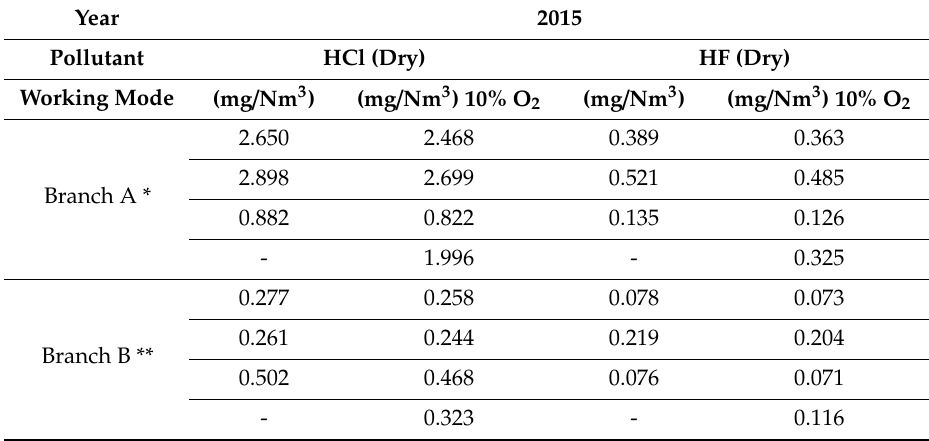
Table 3. Measurement results of HCl and HF of the rotary kiln at the second factory for